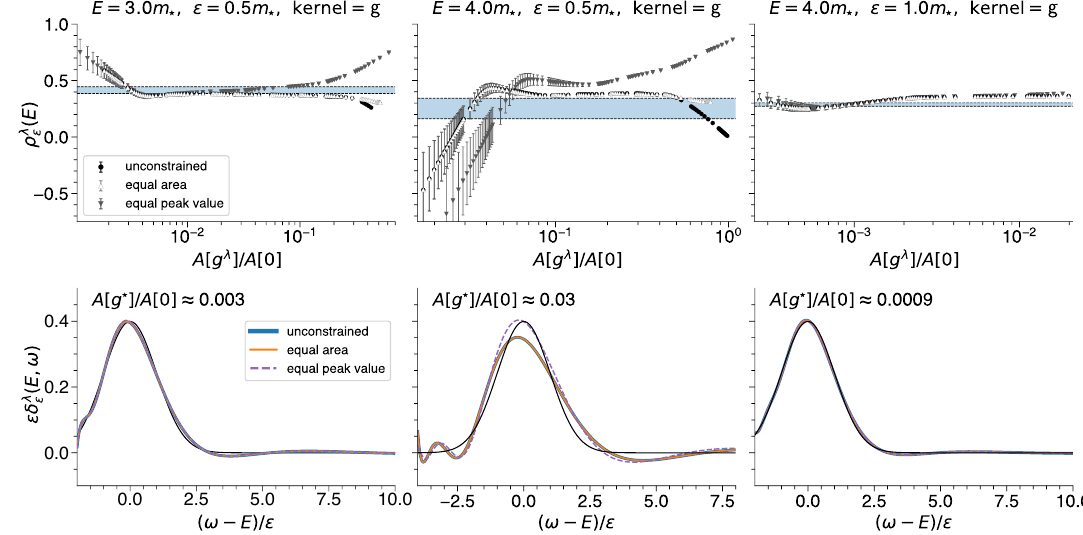
Figure 2 . For the A1 ensemble detailed in table 2, an illustration of the compromise between statistical and systematic errors which results from choosing λ = λ ? . The gaussian kernel δ g is employed for ( E, (cid:15) ) = (3 . 0 m ? , 0 . 5 m ? ) , shown in the left column , ( E, (cid:15) ) = (4 . 0 m ? , 0 . 5 m ? ) in the center column , and ( E, (cid:15) ) = (4 . 0 m ? , 1 . 0 m ? ) in the right column . In each column, the top panel